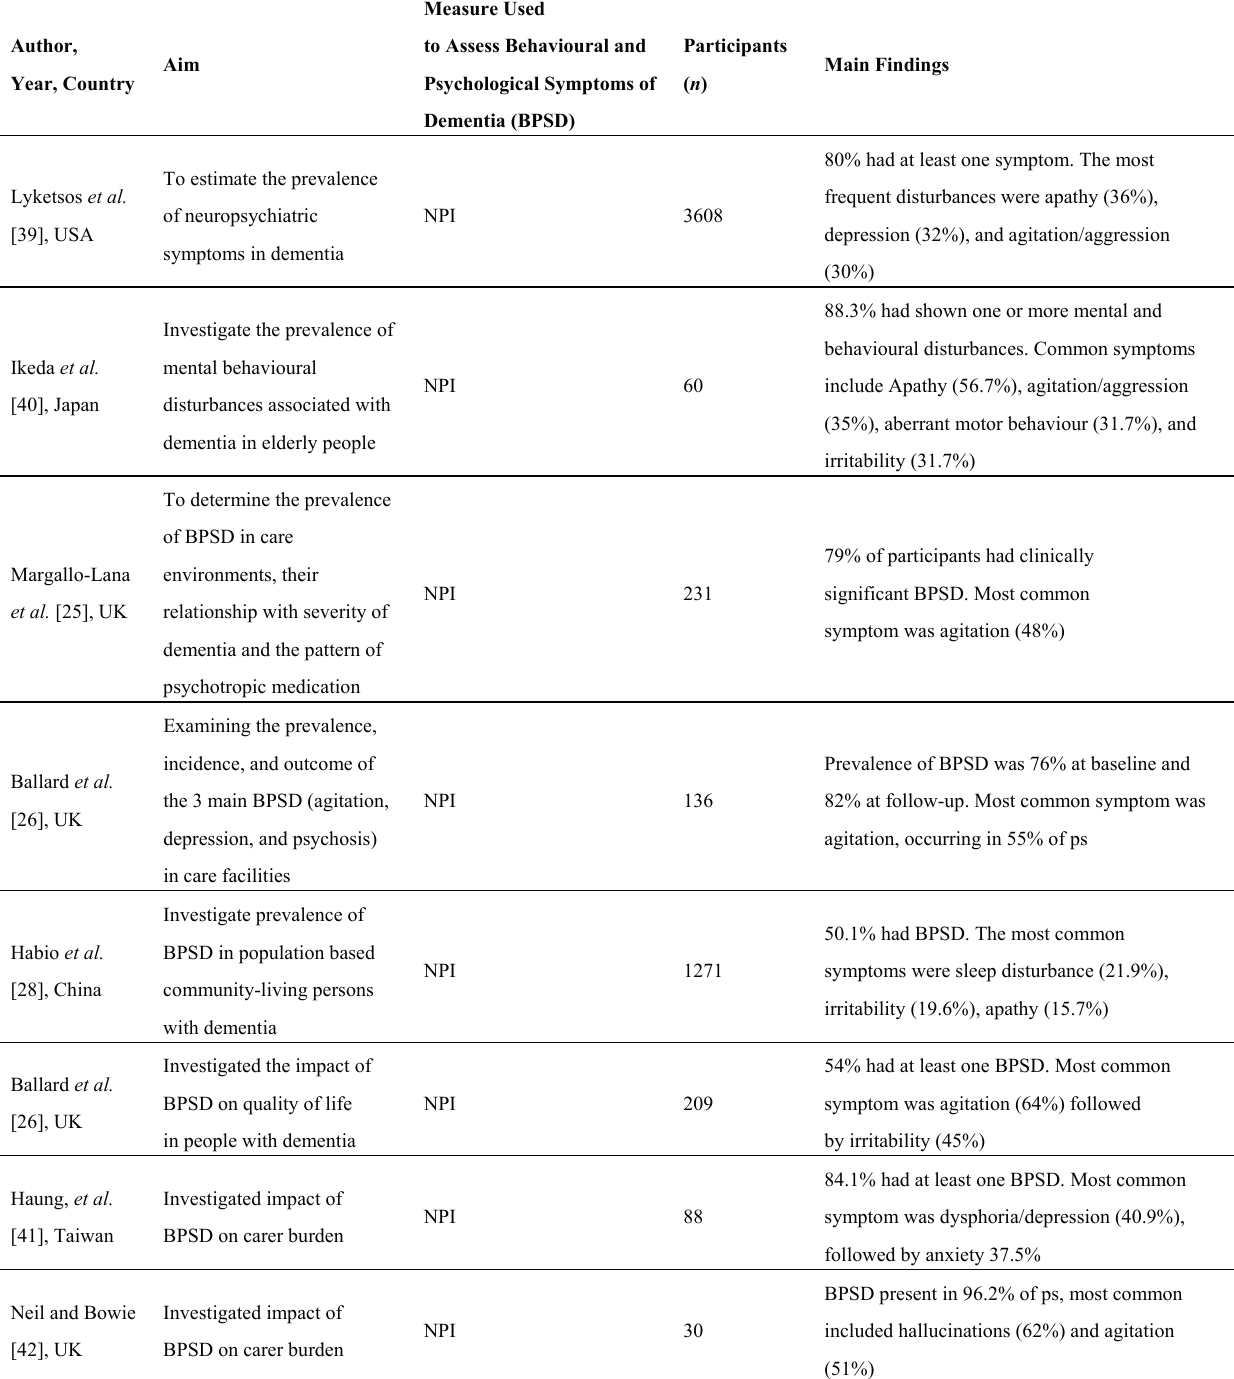
Table 3. Studies using the Neuropsychiatric inventory (NPI) to assess